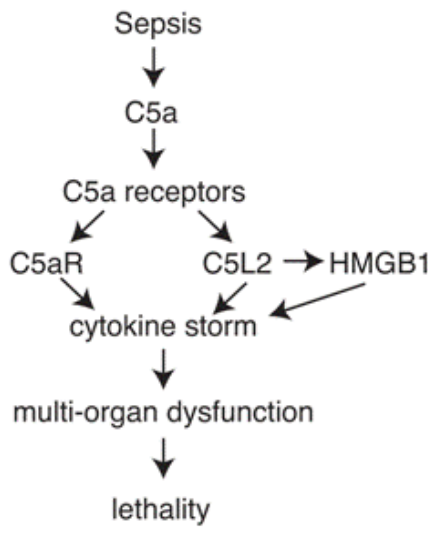
FIGURE 1. Sequence of sepsis, complement activation, and lethality. Roles of C5a interacting with its receptors after onset of sepsis induced by CLP in rodents. The downstream effects are the “cytokine storm”, together with production of HMGB1 from macrophages, which accentuates the cytokine storm. Ultimately, these events lead to multiorgan dysfunction and